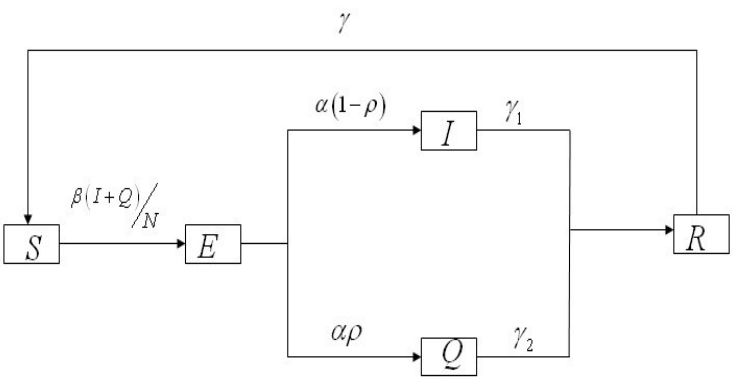
Figure 1. Flow chart of compartments of the HFMD